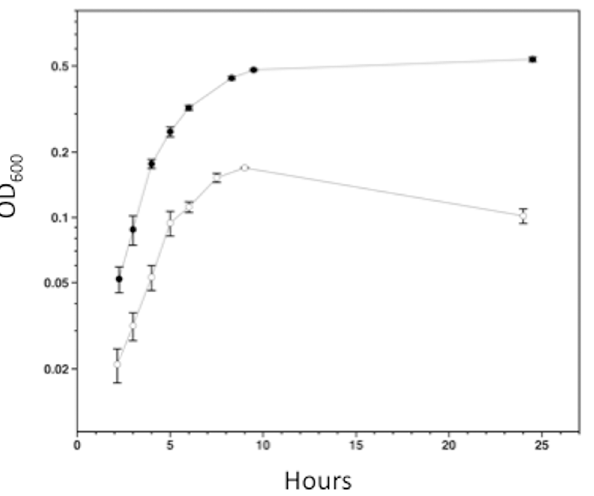
Fig 2. Growth of C . perfringens strain 13 in semi-defined medium in the presence or absence of Neu5Ac. Cells were cultured in medium with (closed circles) or without (open circles) 30 mM Neu5Ac. The values represent the average turbidity ( ± SD) at 600 nm obtained from three independent biological